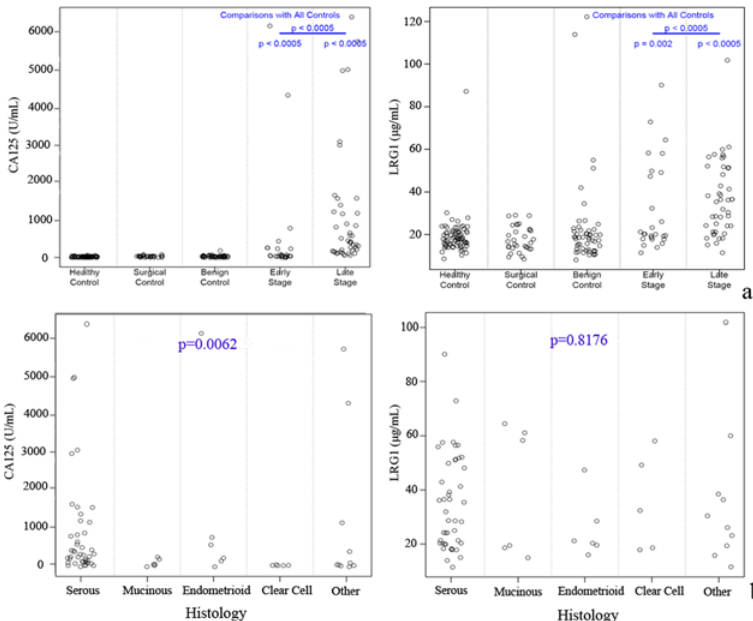
histological subtypes.